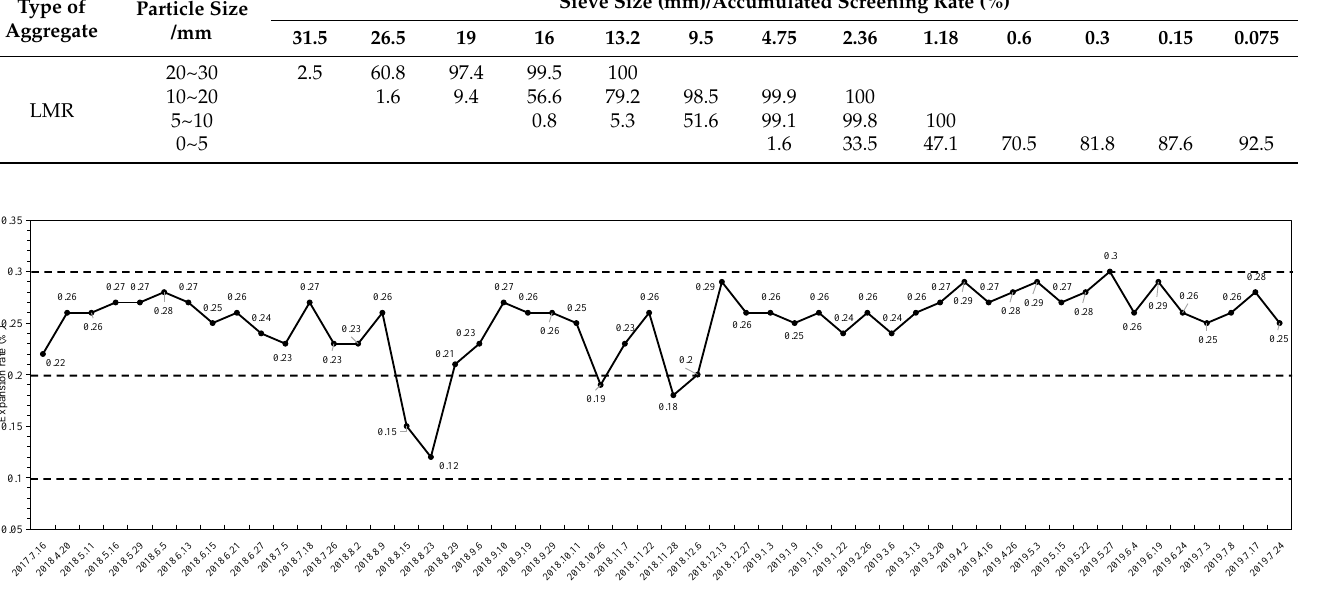
Figure 1. The monitoring results of the alkali activity of LMR. Table 3. The size distribution of LMR aggregates.